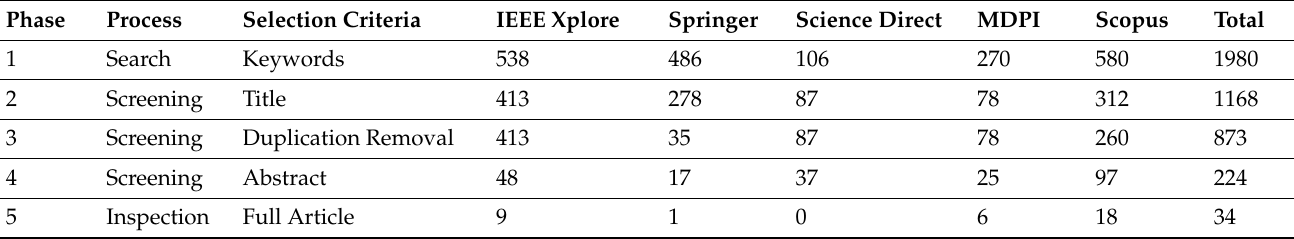
Table 8. Primary selection process for retrieved